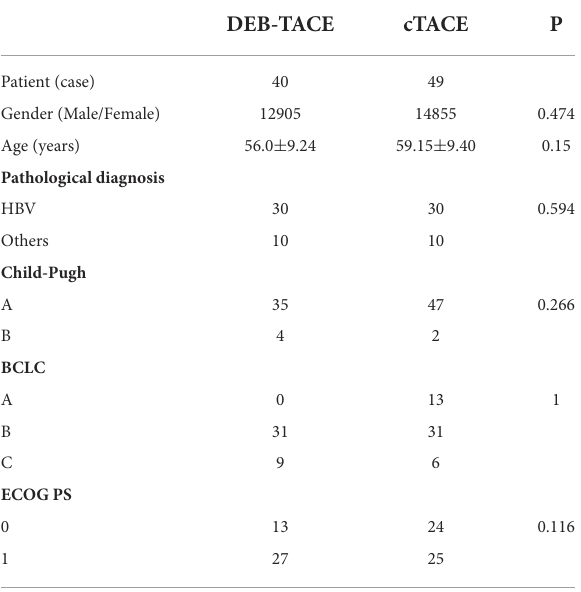
TABLE 1 Baseline characteristics of the